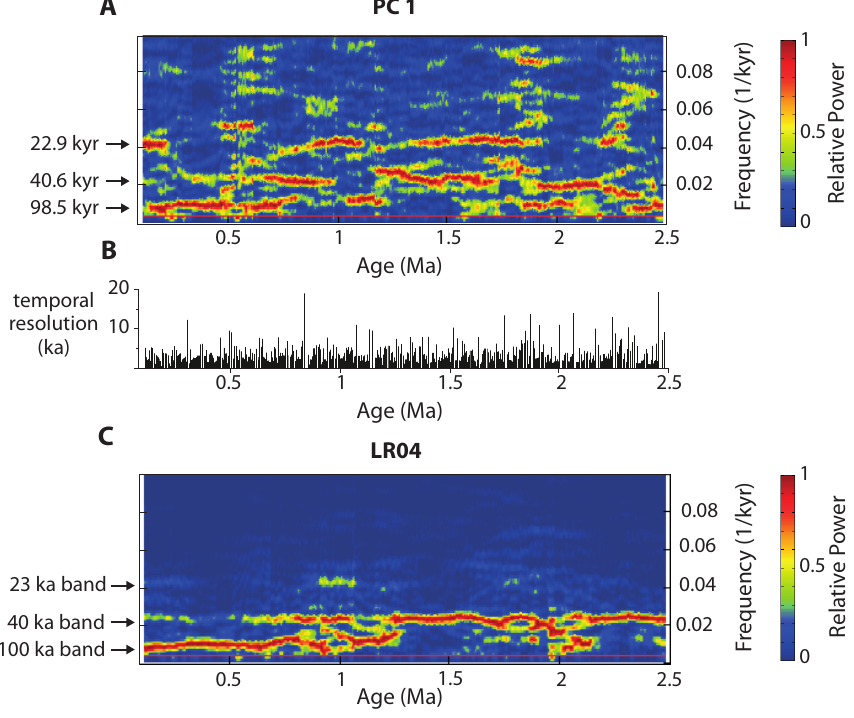
Fig. 6. (A) Evolutionary power spectrum of sample scores of PC1 from 120 to 2478ka, resulting from the chosen window width of 240ka (window type: boxcar). The used software ESALAB (Weber et al., 2010) is based on the same algorithms as REDFIT38. (B) Plot of the temporal resolution of the grain-size data versus time. The length of each bar represents the time period to the next sample below. (C) Evolutionary power spectrum of LR04 (Lisiecki and Raymo, 2005) applying the same settings as in (A) .